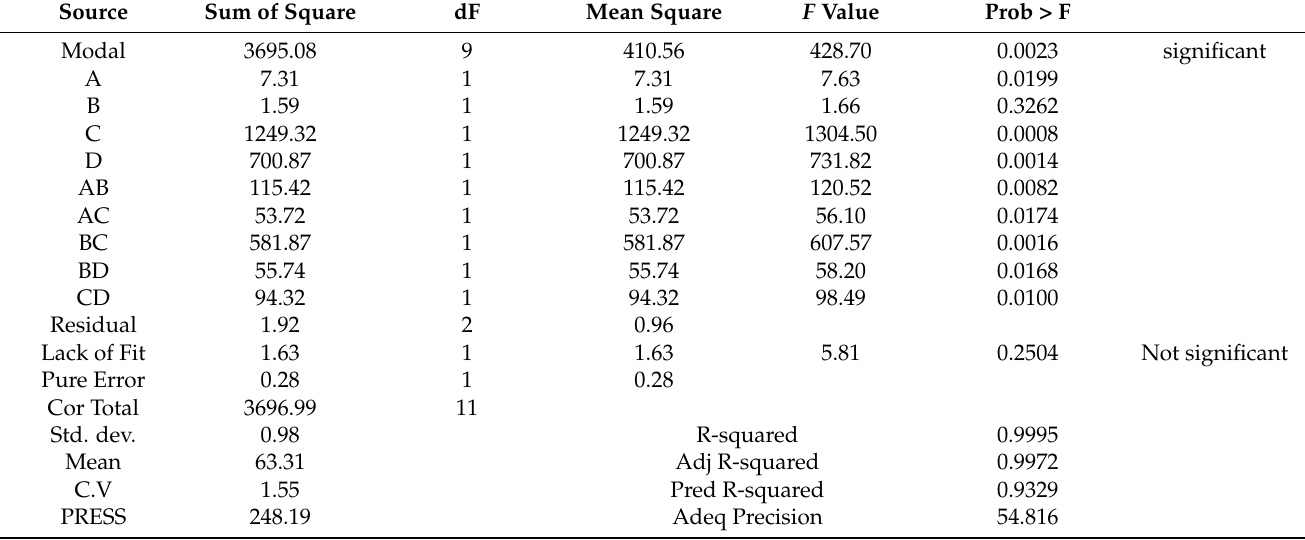
Table 9. Analysis of factors for Plackett-Burman on RR120 decolourisation by consortium JR3.